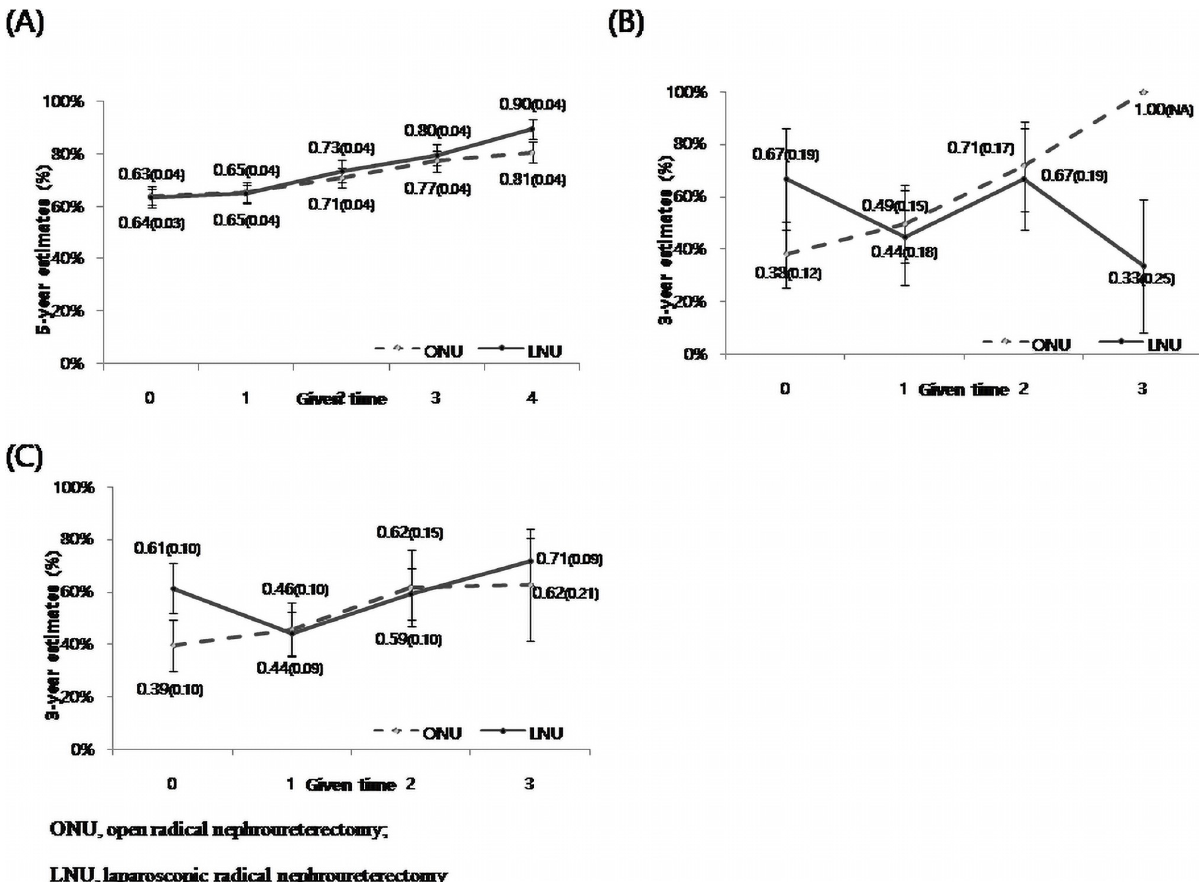
Fig 2. Conditional probability of cancer-specific survival in stage pT3 (A), stage pT4 (B), and stage pN+ (C) upper urinary tract urothelial carcinoma groups according to the surgical approaches in the matched data set (N =